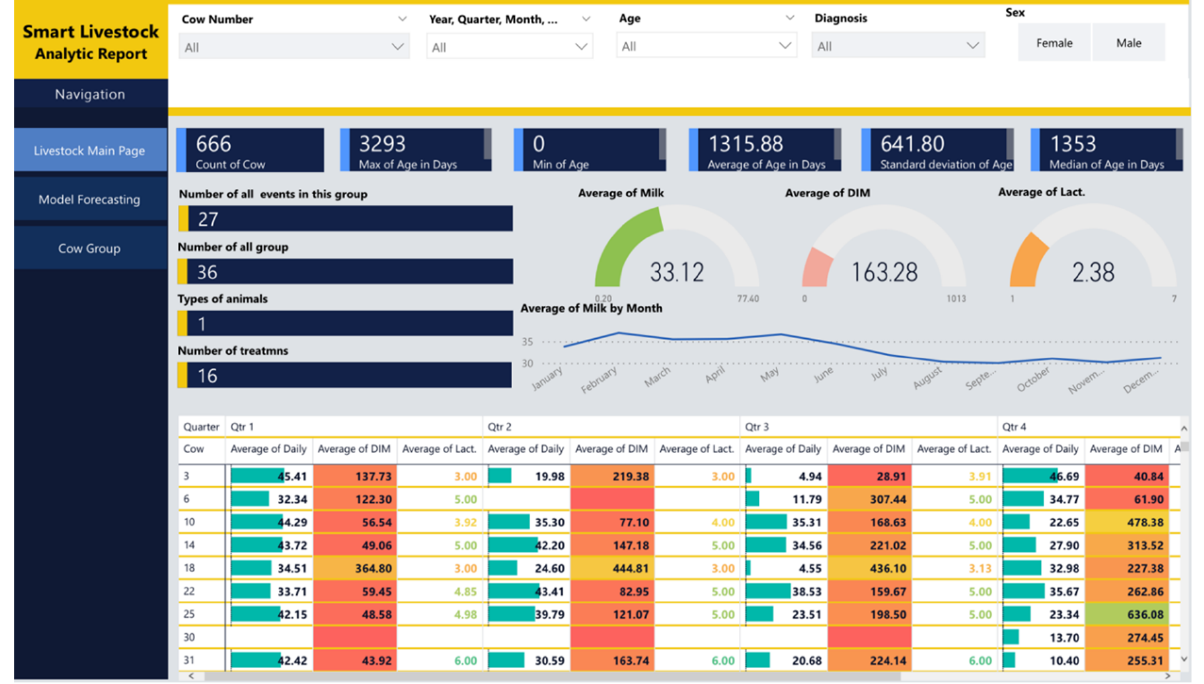
Figure 14. Smart Livestock monitoring system—Analytic report. The data table uses “heat rules” that are restricted to two colors and a gradient in ‐ between. Values above the column average have a green background. Values below column average have a red background. Values close to column average have a gradient background.